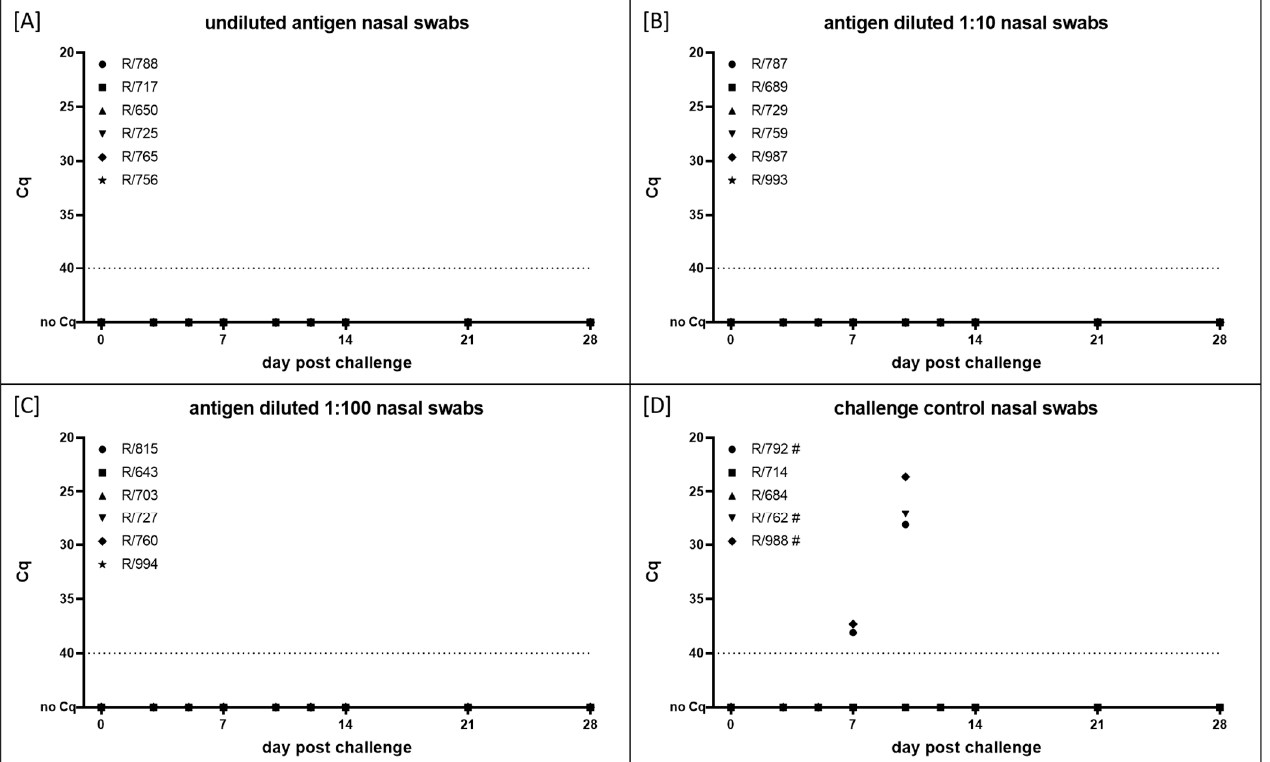
Figure 4. Viral shedding after challenge infection. Animals were inoculated with inactivated LSDV vaccine candidate with different amounts of antigen and then challenged with virulent LSDV ‐ Macedonia2016. ( A ) Vaccine virus titer before inactivation was 10 6 CCID 50 /mL on BHK ‐ 21 cell line. ( B , C ) Antigen was diluted 1:10 and 1:100, respectively, before adjuvant was added. ( D ) Cattle in group D were housed as challenge control group and received PBS instead of vaccine. Cut ‐ off was set at Cq 40.0.